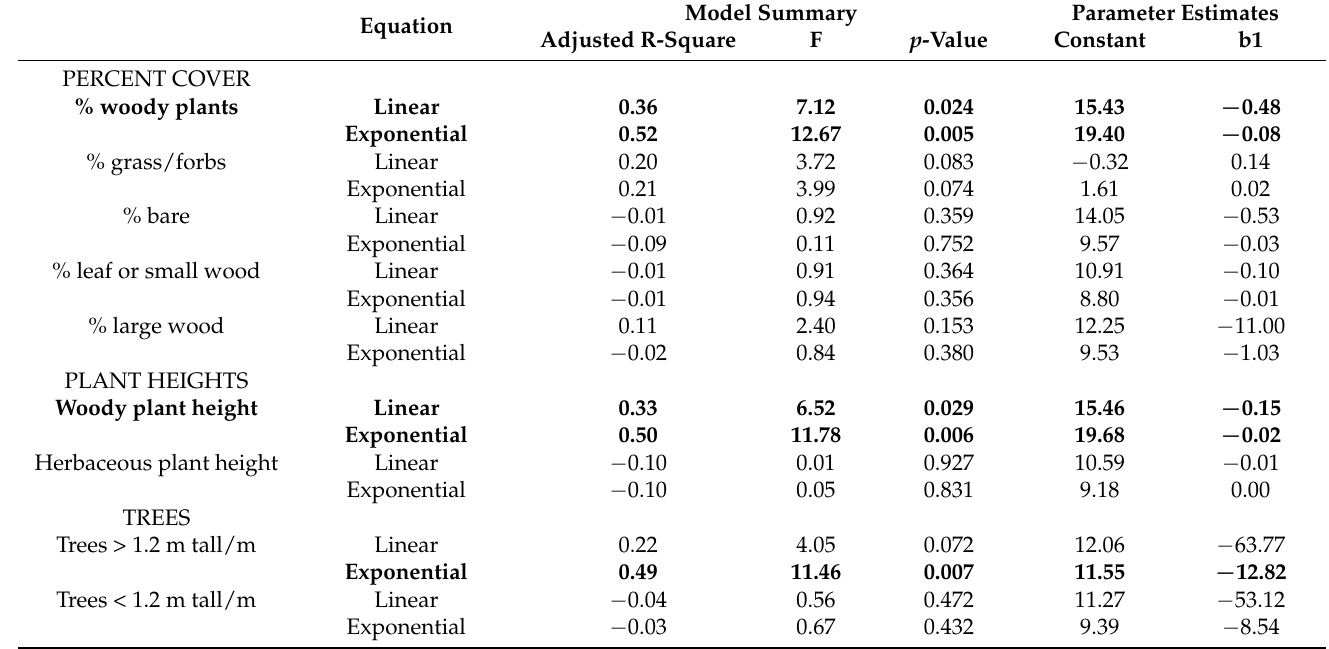
Table 4. Curve-fitting results for univariate models of habitat characteristics versus number of burrows. Independent variables were habitat characteristics from quadrats averaged over each site. The dependent variable was the number of active burrows in quadrats totaled by transect then averaged over each site. Degrees of freedom 1 and 2 were 1 and 10, respectively, for all tests; N = 12. Models with p < 0.05 are in